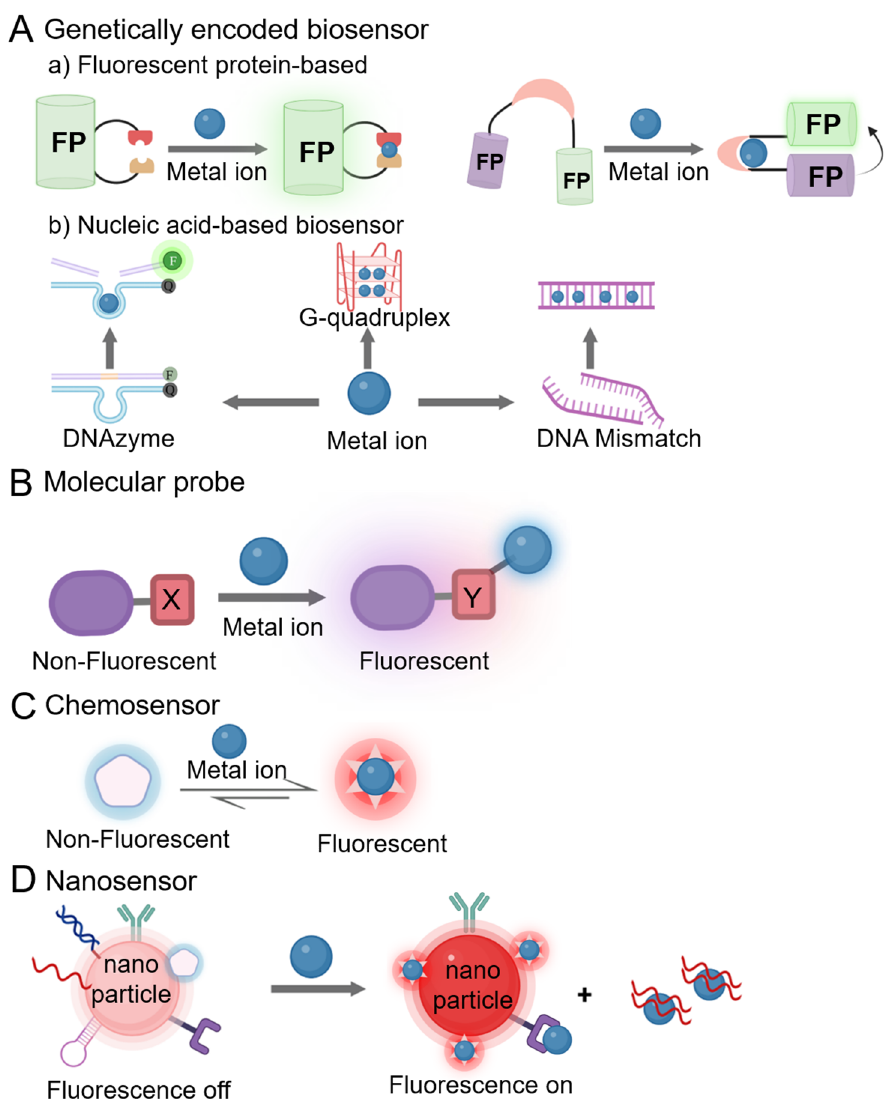
Figure 1. Schematic representation of genetically encoded biosensors, molecular probes, chemosen- sors, and nanosensors. An emission turn-on response is shown as an exemplary signal response to the presence of an analyte. ( A ) Genetically encoded biosensors: ( a ) fluorescent protein-based biosensors; ( b ) nucleic acid-based biosensors; ( B ) molecular probes; ( C ) chemosensors; ( D ) nanosen- sors.